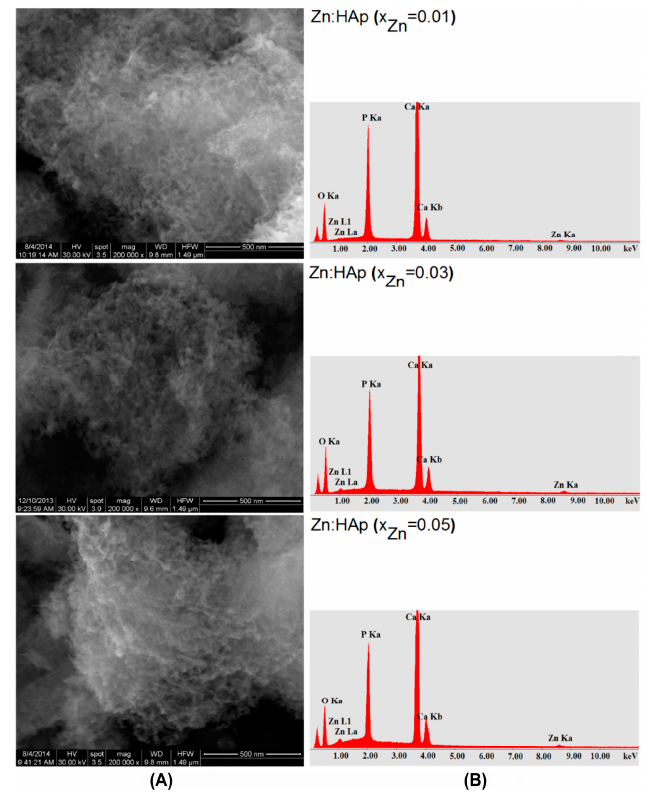
Figure 4. Scanning electron microscopy (SEM) images ( A ); and the EDAX analysis ( B ) of Zn:HAp, samples with 0.01 ≤ x Zn ≤ 0.05.